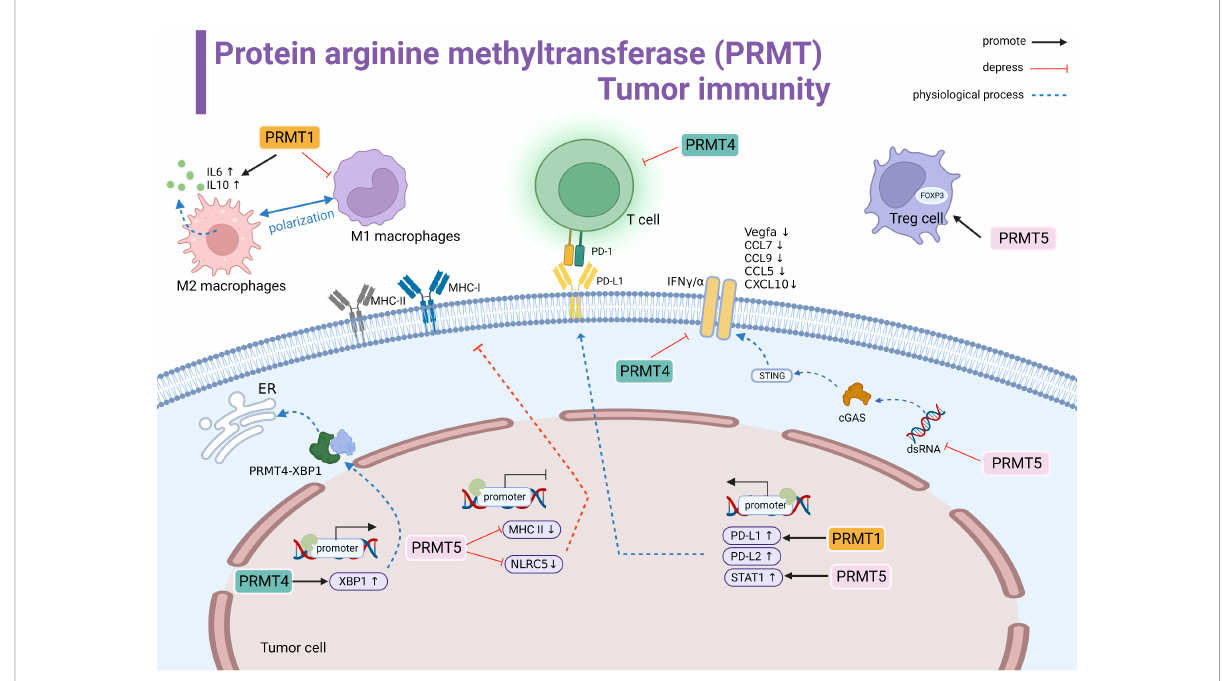
FIGURE 2 Protein arginine methyltransferase (PRMT) involved in tumor immune summary. PRMT1 regulates M2 macrophage polarization and promotes the transcription of IL-6 and IL-10. PRMT1 promotes the transcriptional level of PD-L1. PRMT4 negatively regulates T cells. PRMT4 promotes the transcription of XBP1 and forms the PRMT4-XBP1 complex to activate the endoplasmic reticulum stress pathway. PRMT5 inhibits the transcription of MHCI and MHCII and suppresses antigen recognition. PRMT5 promotes STAT1 expression to promote PD-L1 expression levels. In the cytoplasm, PRMT5 inhibits the dsRNA-cGAS-STING pathway, downregulates the interferon pathway, and downstream genes Vegfa, CCL7, CCL9, CCL5, and CCL10 expression are suppressed.PRMT4 inhibits IFN g / a .PRMT5 promotes the immunosuppressive function of Foxp3 regulatory T cells. Black line indicates promotion, red line indicates suppression, and dashed line indicates physiological